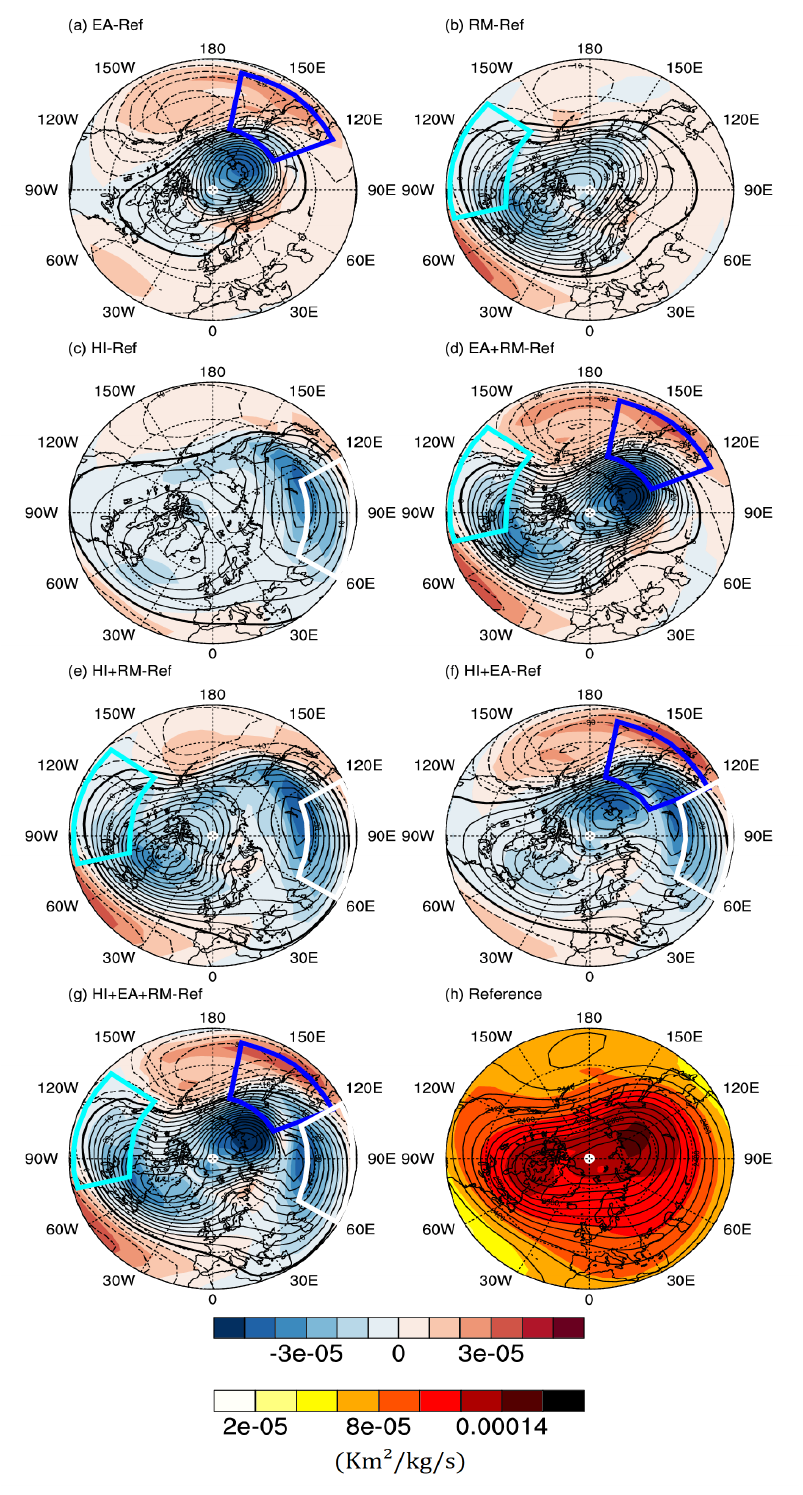
Figure 4. Geopotential height differences (contour lines) and potential vorticity differences (color coding) between each experiment ( a )–( g ) and the Ref simulation, averaged between 20 and 30 km. Latitudes range from 30 ◦ N to the pole. Geopotential differences are presented in intervals of 5 m. The zero lines are highlighted. Dashed (solid) lines represent negative (positive) differences. The positions of the GW hotspots are illustrated by the boxes. Geopotential heights and potential vorticity from the Ref simulation are shown in panel ( h